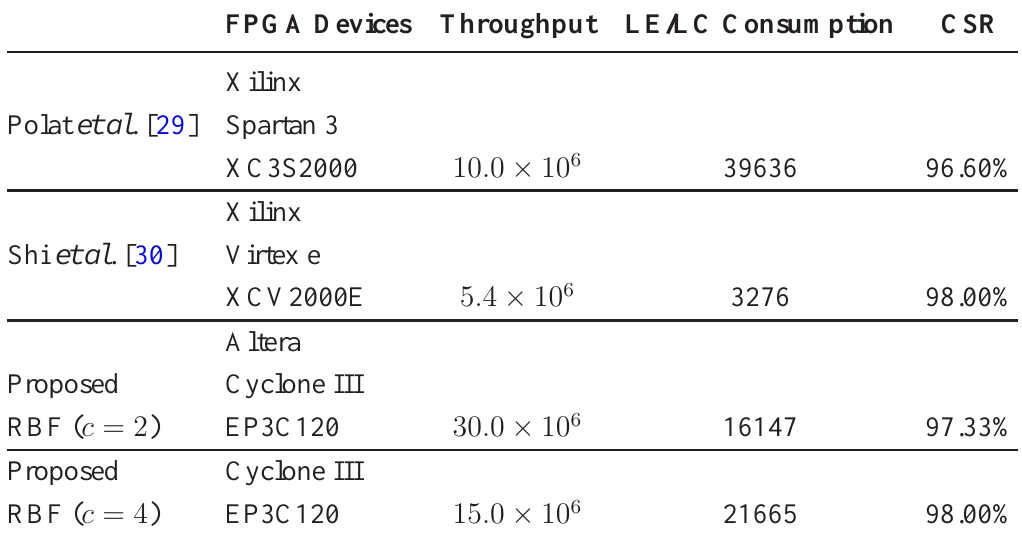
Table 10. Comparisons of different hardware architectures for Iris classification.